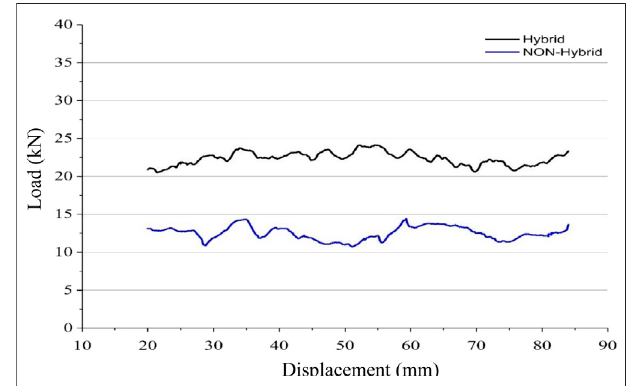
FIGURE 4 | Representative load vs. displacement and collapse history of the corrugated HCS with three layers. FIGURE 5 | A comparison of sustained load between hybrid and nonhybrid composite specimens at postcrushing stage.